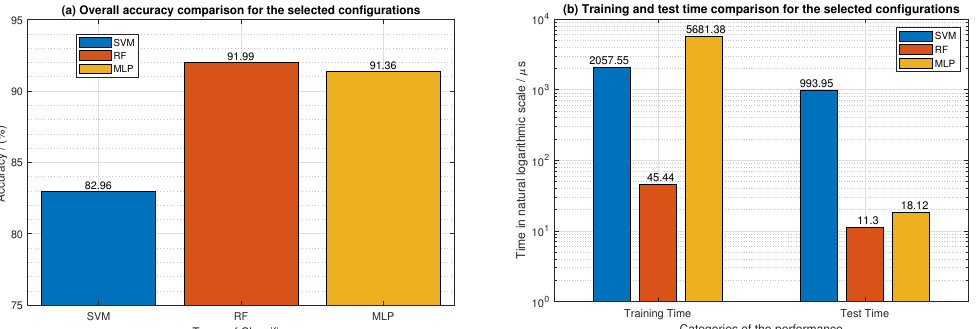
Figure 4. Summary of the chosen configurations for the three classifiers, which is the RBF kernel for SVM, 50 estimators for RF, and three hidden layers with 100 neurons in each for MLP. ( a ) Overall accuracy comparison for the selected configurations ( b ) Training and test time comparison for the selected